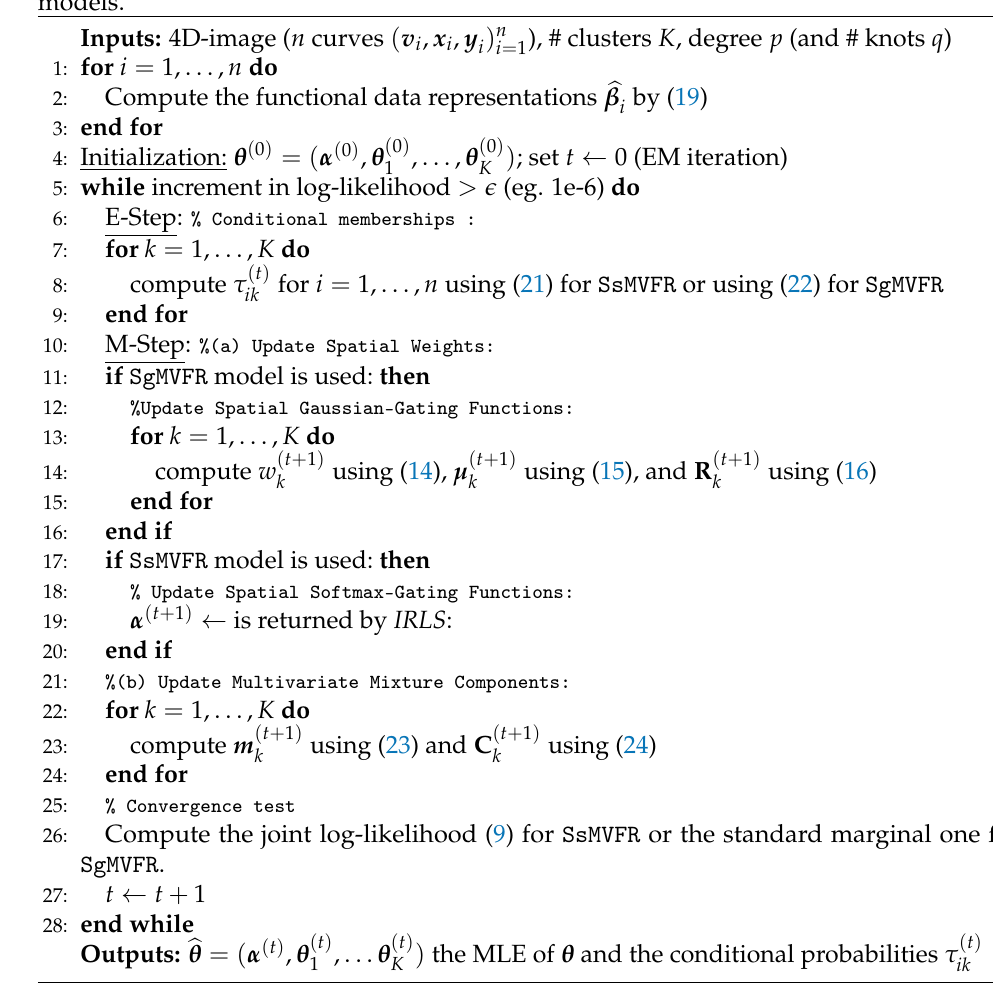
Algorithm A2 Pseudo code of DECT-CLUST with alternative SgMVFR and SsMVFR